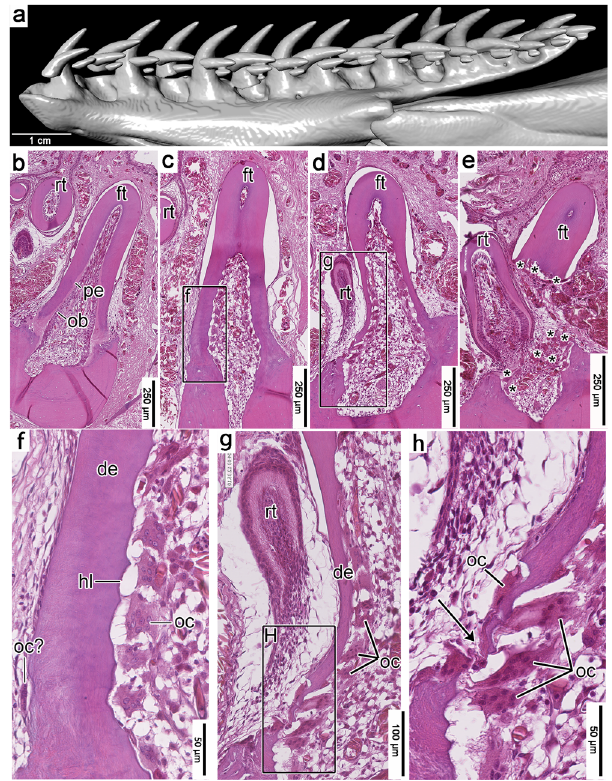
Fig. 2 | Histology of snake-type tooth replacement in the sea snake Hydrophis cyanocinctus (hematoxylin and eosin staining). a CT surface rendering of a dentary of H. cyanocinctus (SAMA R70272) in lingual view. b Recently attached dentary tooth in coronal section. Note the lining of odontoblasts and lighter- colored predentine along the inner walls of the tooth. c Tooth resorption inside a functionalmaxillarytooth( fl ippedforcomparisons). d Late-stagetoothresorption and initial pulp breach from within a dentary tooth. e Tooth shedding and near simultaneous tooth replacement in a palatine tooth ( fl ipped vertically for con- sistency). f Closeupoflingualdentinewallincshowingsmooth,nearlyunresorbed externalsurface and a scalloped,partially resorbed,and odontoclast-lined internal surface. g Closeupoflingualsurfaceoffunctionaltoothandreplacementtoothind showing extensive internal resorption and a very small pulp breach along the base of the functional tooth. h Closeup of the small pulp breach in g showing a small population ofodontoclasts to the external surfaceof the tooth base. dedentine,ft functional tooth, hl Howship ’ s lacuna, ob odontoblasts, oc odontoclasts, pe pre- dentine, rtreplacement tooth. Arrowhead indicates position of pulp breach in (H). Asterisks in (E) mark